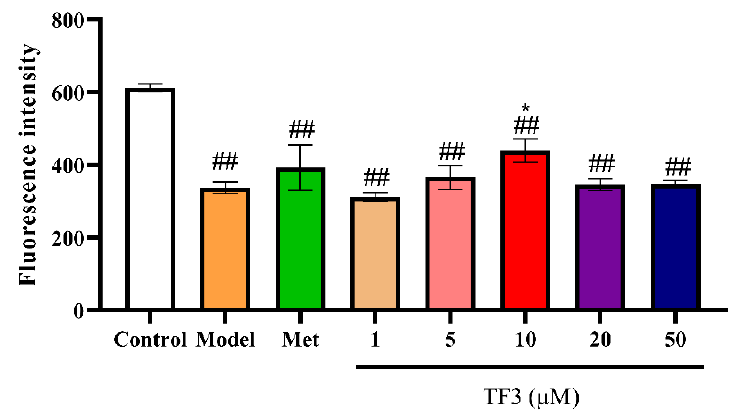
Figure 2. TF3 treatment recovered glucose uptake in glucose-treated insulin resistance HepG2 cells. Control, DMEM medium culture; model, DMEM medium with 500 µ M glucose treating for 24 h; TF3, DMEM medium containing different concentrations of TF3 (1, 5, 10, 20, 50 µ M) treating for 24 h after glucose-treatment; Met, DMEM medium containing metformin hydrochloride (10 µ M) treating for 24 h after glucose-treatment. * p < 0.05 versus model group, ## p < 0.01 versus control group.